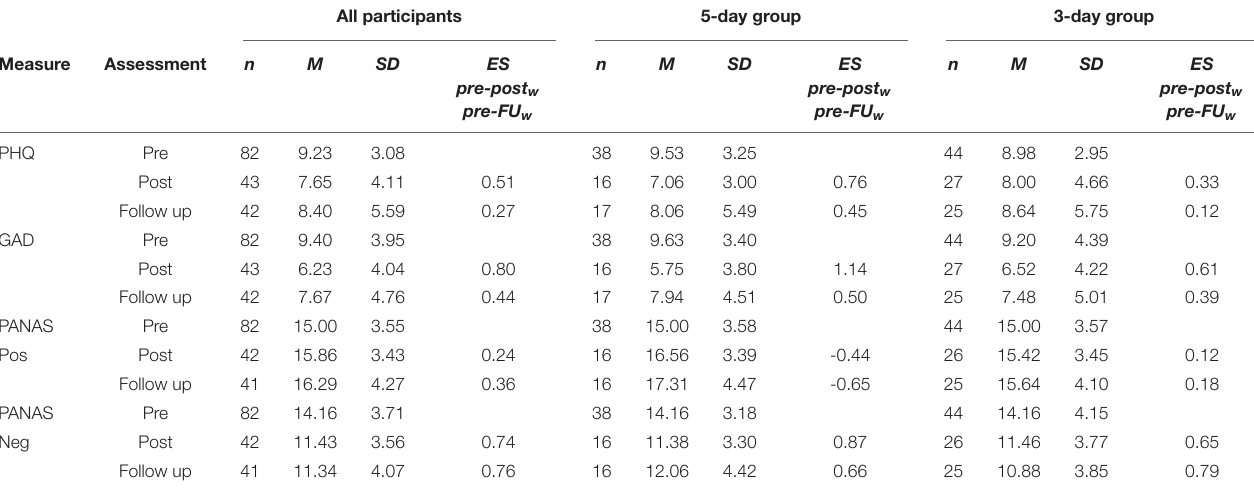
TABLE 5 | Observed Means, Standard Deviations, and Effect sizes for Primary and Secondary Outcome Measures at Pre, Post, and Follow-up. All participants